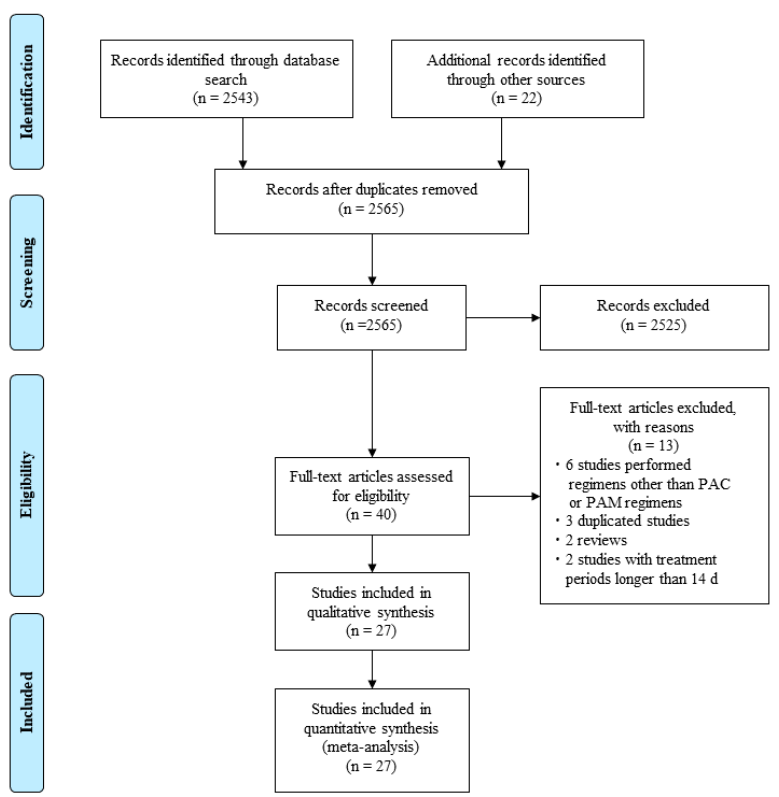
Figure 1. Workflow for the selection of studies comparing eradication rates between PAC and PAM therapy. Abbreviations: D, day; PAC, proton pump inhibitor/amoxicillin/clarithromycin; PAM, proton pump inhibitor/amoxicillin/metronidazole.